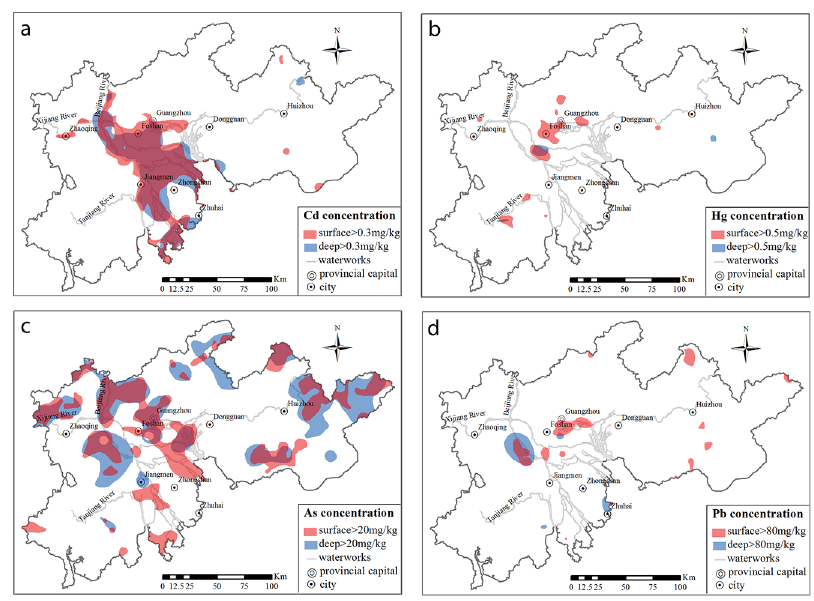
Fig 3. Distribution of high-concentration heavy metals in the soil of the PRD. (a) Cd; (b) Hg; (c) As; and (d) Pb.